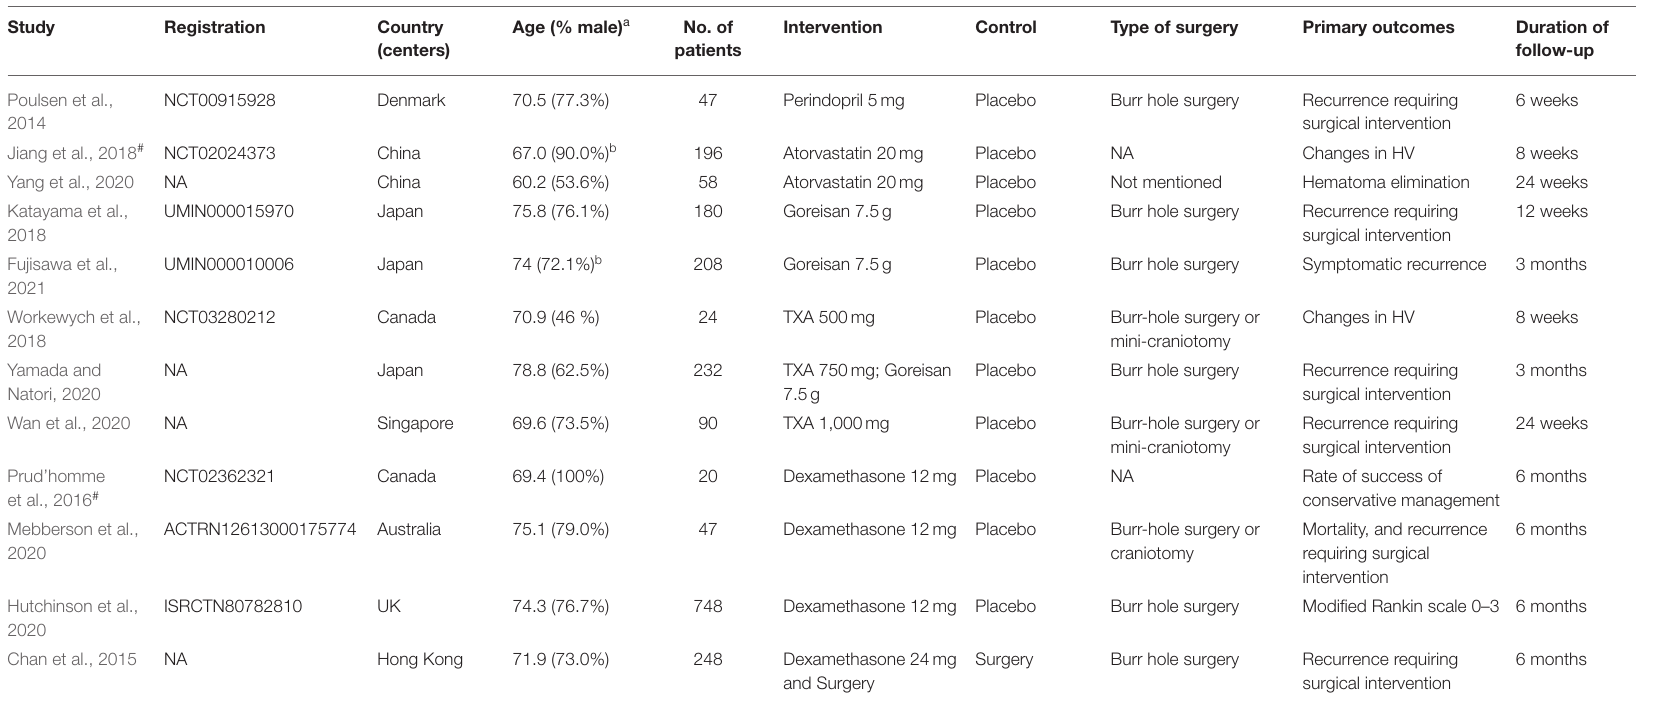
TABLE 1 | Characteristics of studies included in the systematic review and network